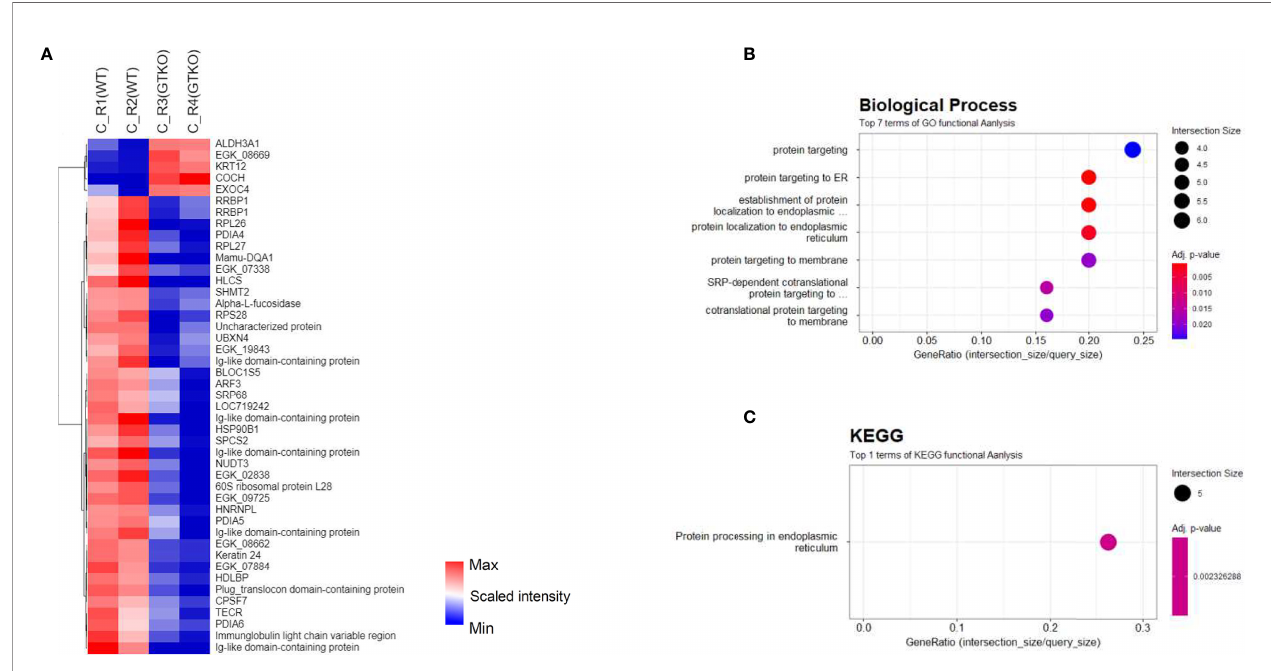
FIGURE 5 | Proteomic analysis of the subgroups in corneal tissue. (A) Cluster heat map of differentially expressed proteins (DEPs) comparing subgroups transplanted with wild-type (WT) or a -1,3 ‐ galactosyltransferase gene ‐ knockout (GTKO) porcine corneas in the rejection (R) group. (B, C) Gene Ontology biological process classi fi cation (B) and Kyoto Encyclopedia of Genes and Genomes (KEGG) pathway enrichment analyses (C) of the DEPs between subgroups transplanted with WT and GTKO porcine corneas in the R group. Node size represents the gene ratio; node color represents the adjusted p